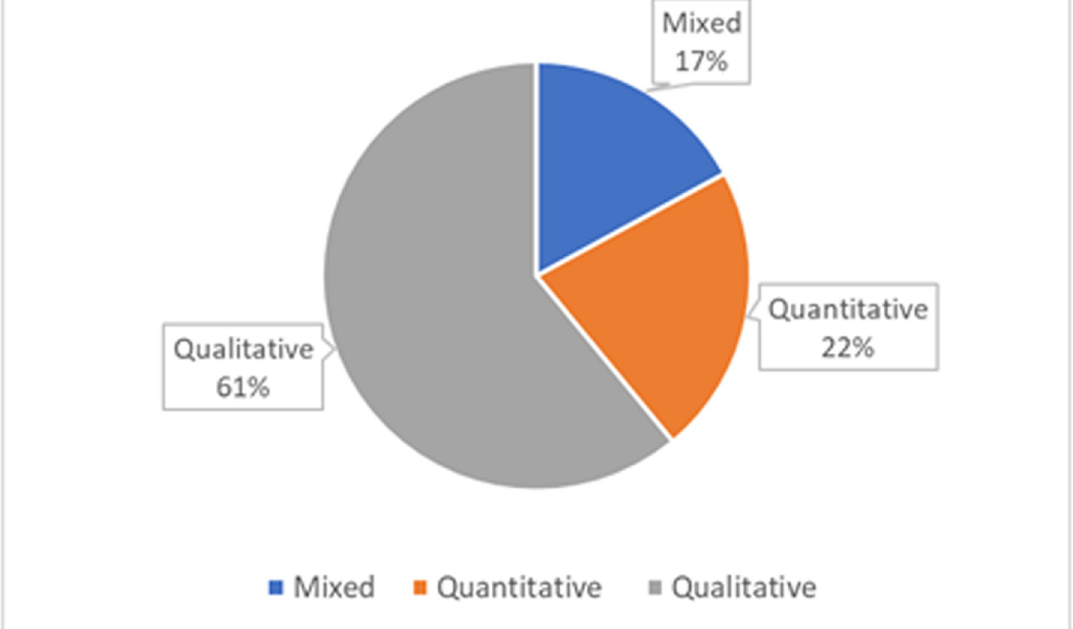
Fig 5. Distribution of research methods in OER-in-Africa